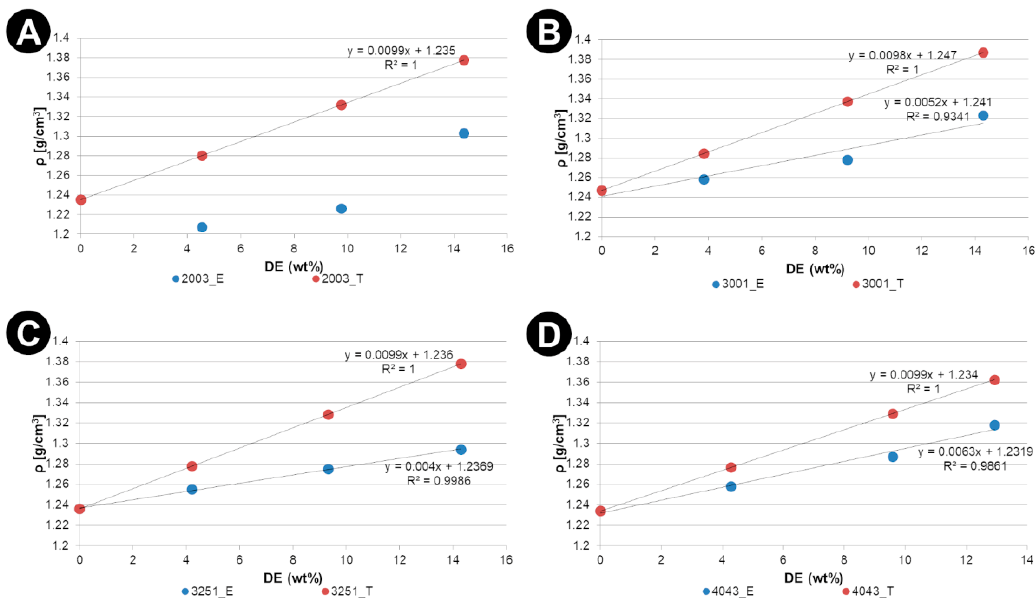
Figure 3. The average density of the manufactured samples against DE weight content in composites with ( A ) 2003D; ( B ) 3001D; ( C ) 3251D and ( D ) 4043D PLA matrices: E—experimental , T—theoretical . Images in Figure 4 reveal two major forms of the pores/voids: (a) delamination be- tween frustules and PLA matrix, (b) unimpregnated cavities of the frustules.